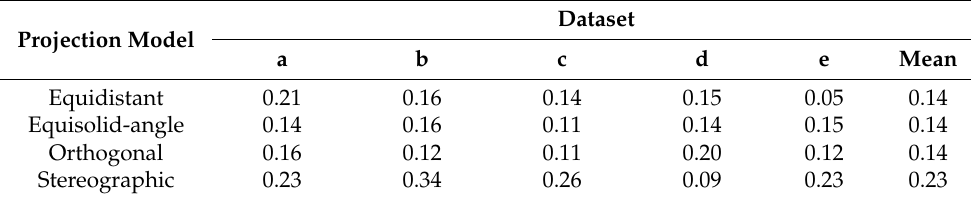
Table 6. Absolute error of principal point coordinates (pixel) in simulation experiments.